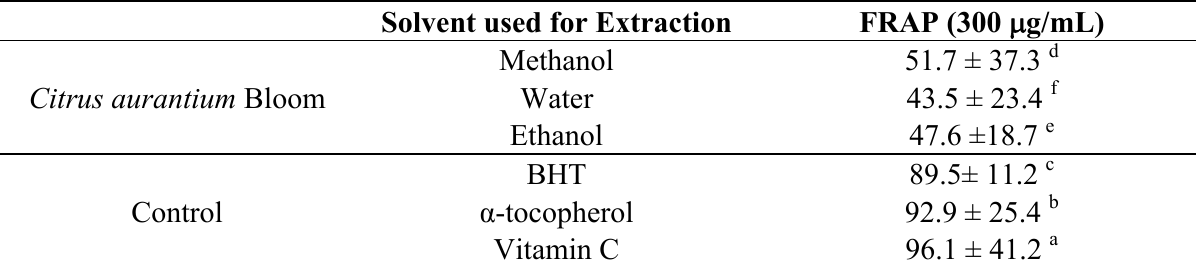
Table 4. FRAP activity of Citrus aurantium extracts using different solvents (methanol, boiling waterand ethanol). BHT, α -tocopherol and vitamin C were used as positive